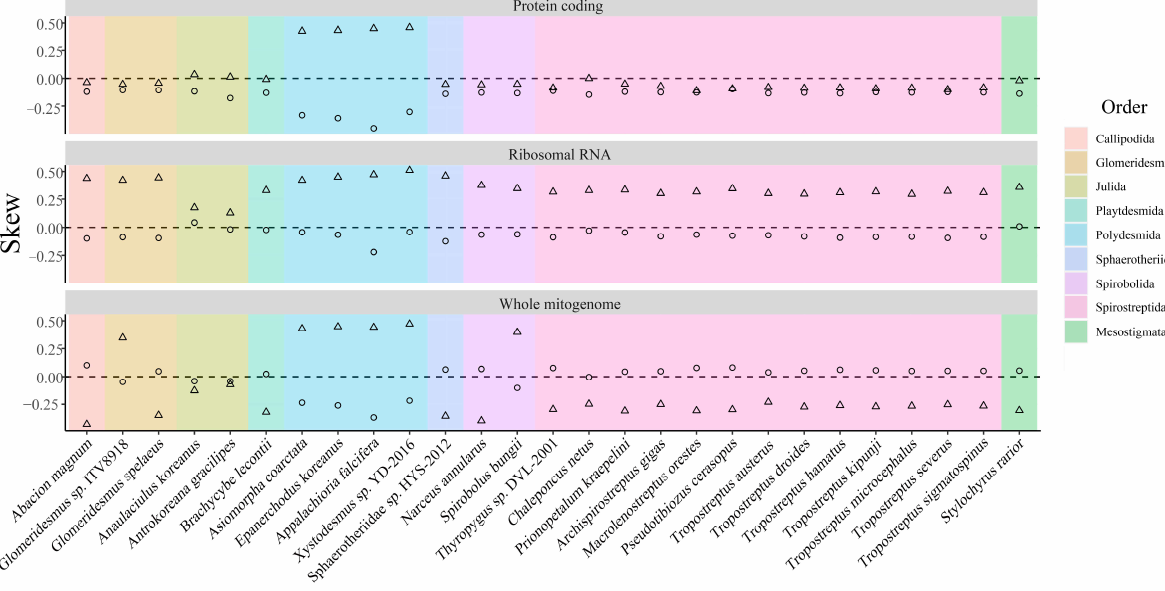
Figure 2. AT-skew (circle) and GC-skew (triangle) of 27 species used in this study.